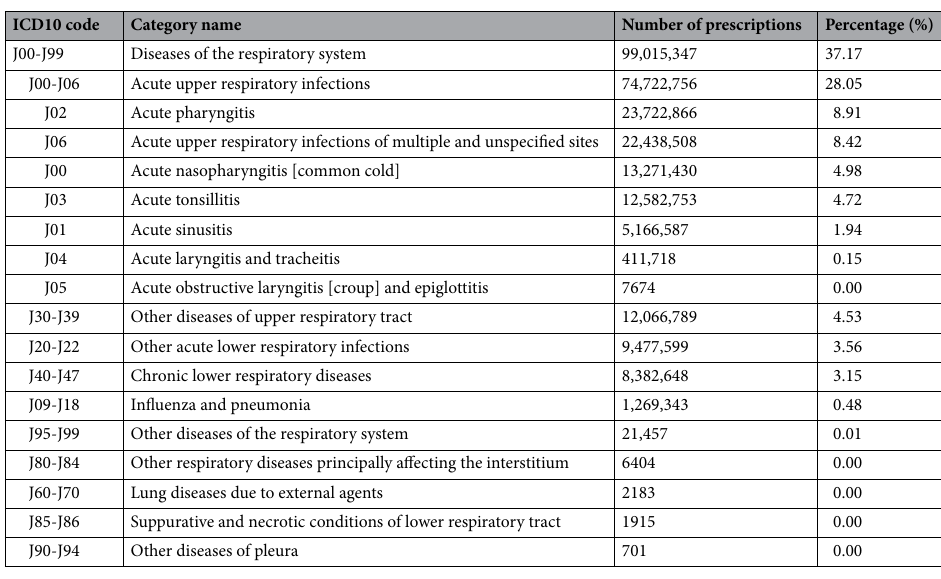
Table 1. Number of prescriptions with “diseases of the respiratory system” (i.e., ICD10 chapter J00-J99) diagnosis and corresponding